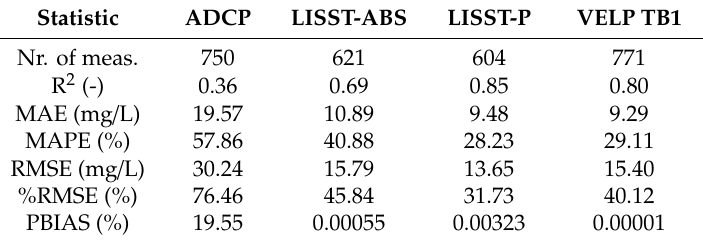
Table 2. Results of statistical analysis of indirect